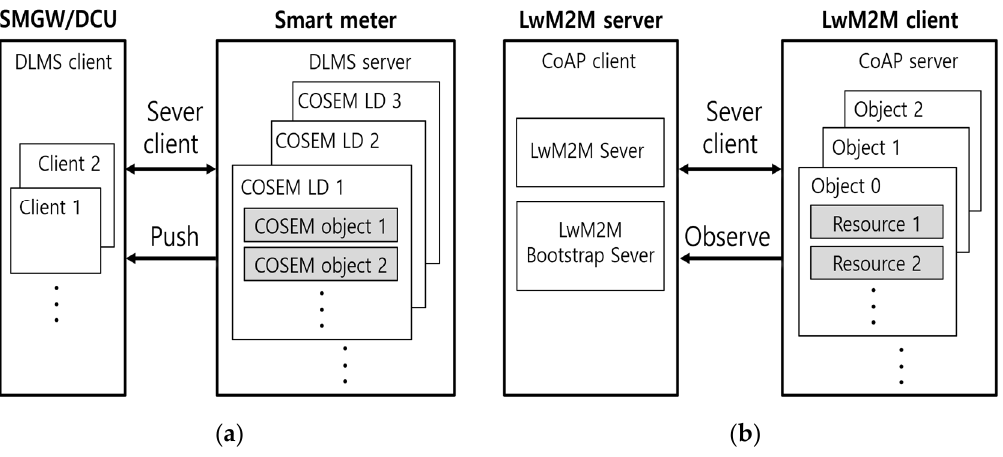
Figure 3. Service models. ( a ) DLMS service model; ( b ) LwM2M service model.